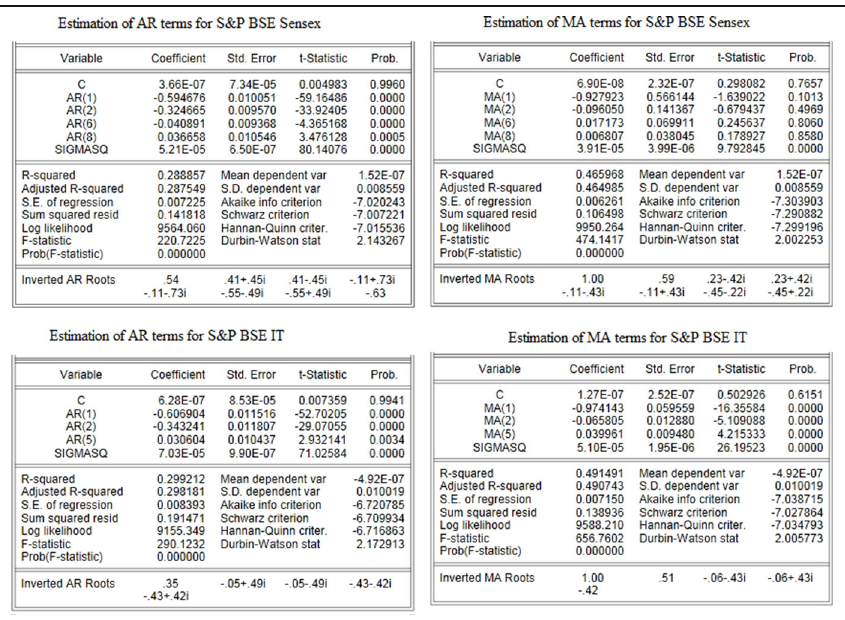
Table 7 AR and MA terms Estimation for S&P BSE Sensex and IT